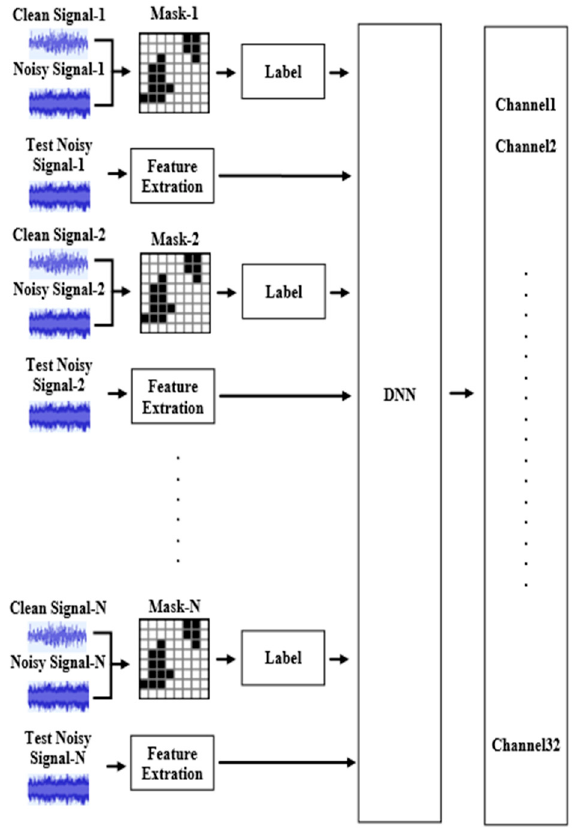
Figure 10. DNN training Mask architecture diagram.